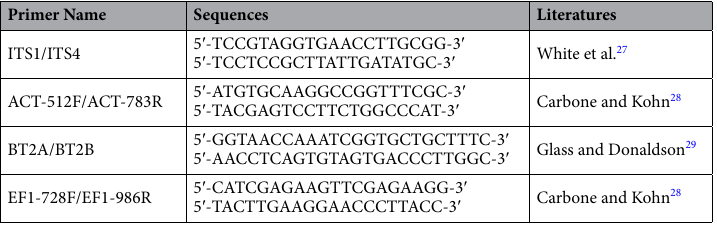
Table 3. The primers used in the